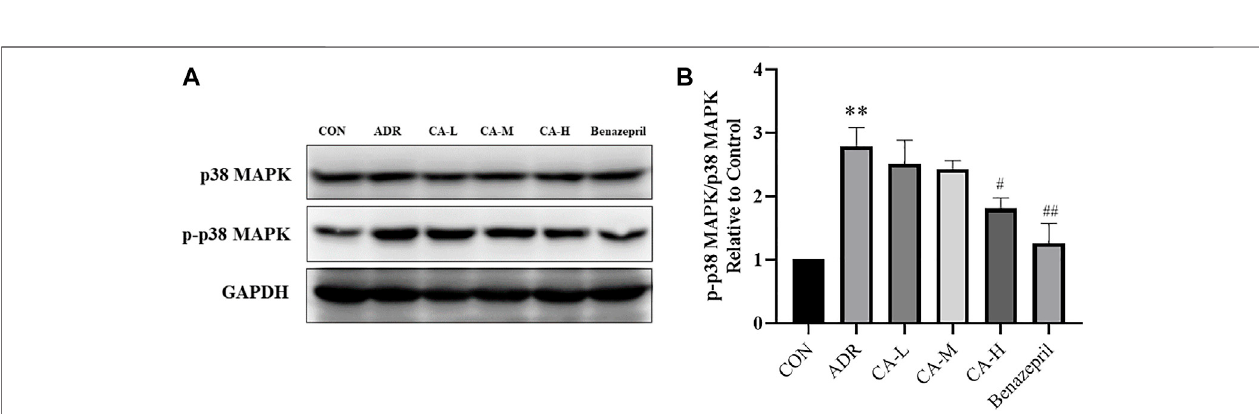
FIGURE 13 | The protein expression of p-p38 MAPK (A) was detected by western blotting, and the gray value was calculated by Image J (B) . ** p < 0.01 vs . CON group; # p < 0.05, ## p < 0.01 vs. ADR group.